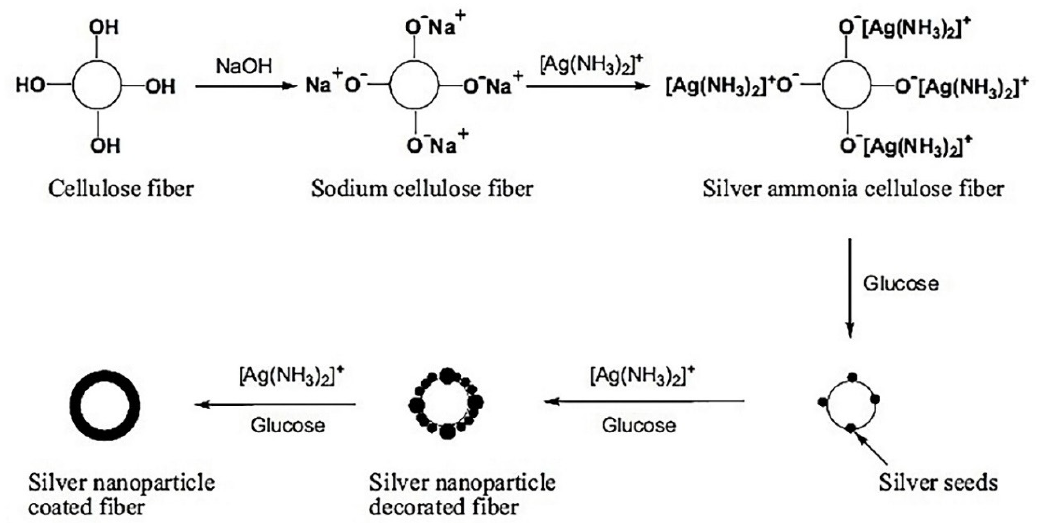
Figure 7. Formation of AgNP coated fibers [54].